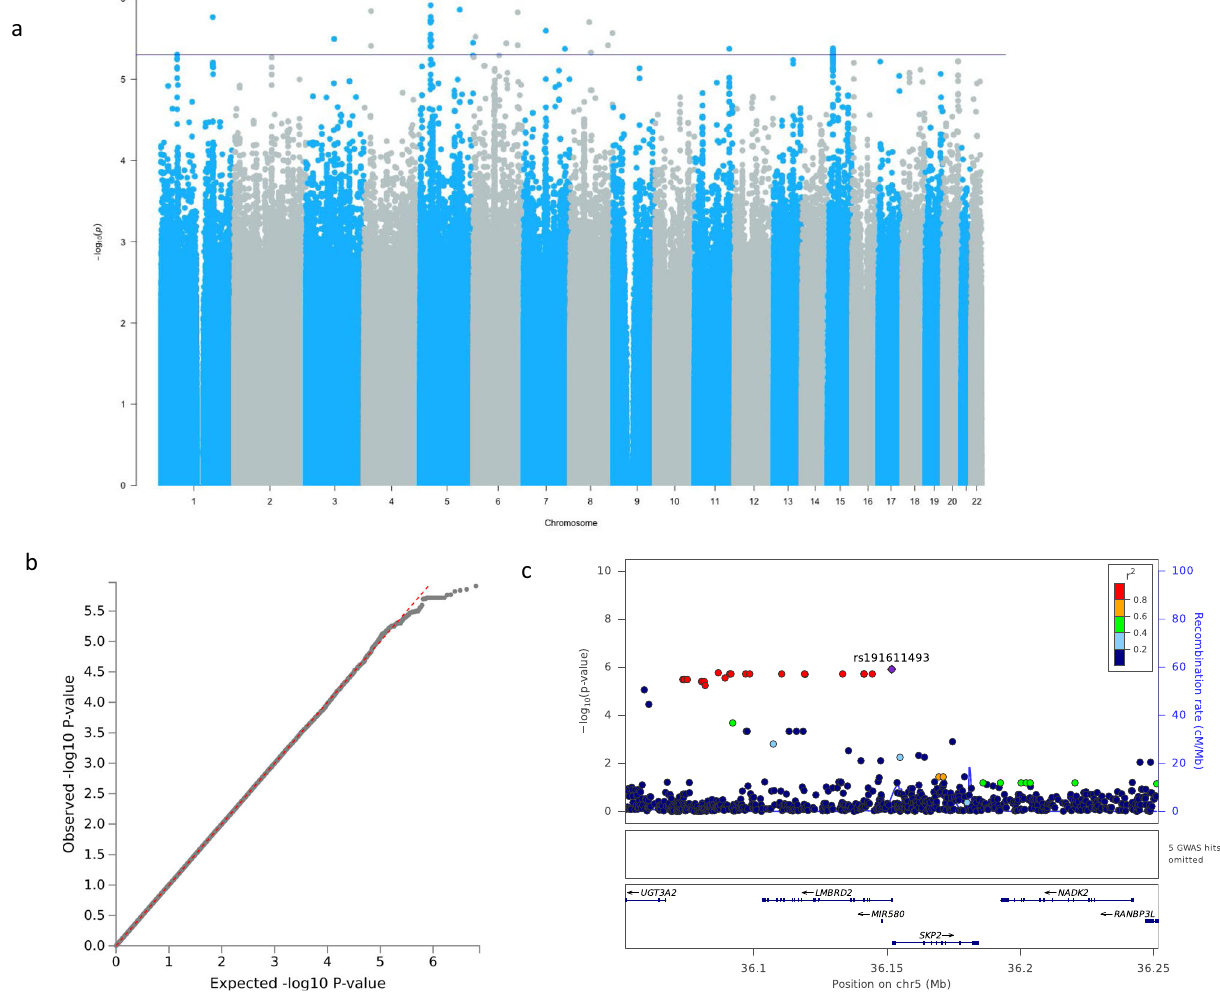
Fig. 4 Genome-wide and suggestive associations with visuospatial ability. a Manhattan plot. No genome-wide or near genome-wide signi fi cant signals. Suggestive cut-off 5 × 10 − 6 shown by a blue line. b QQ-plot ( λ = 1.00) for association summary statistics. c Locus zoom plot for rs191611493. LD values are based on a South African LD